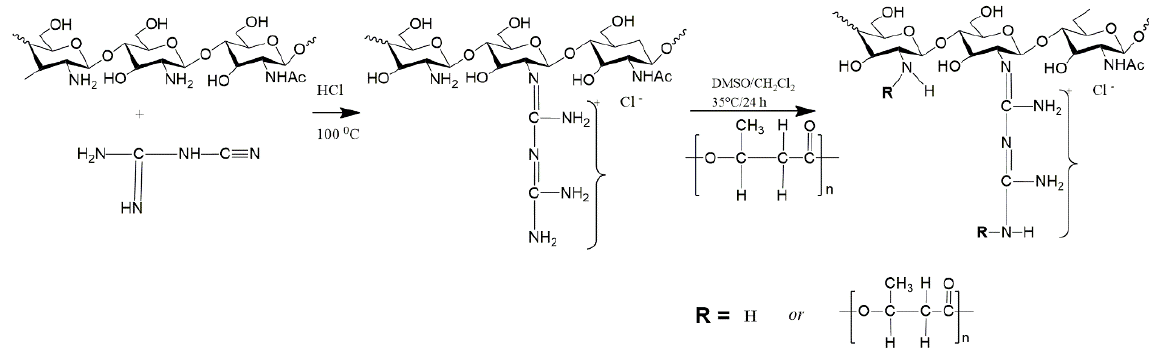
Figure 4. ChG − grafted PHB copolymer. Adapted from [137].